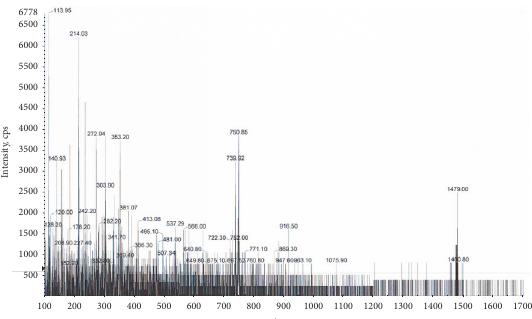
Figure 5: ESI-MS spectrum of purified hydrolysed lipid (hGDNT).